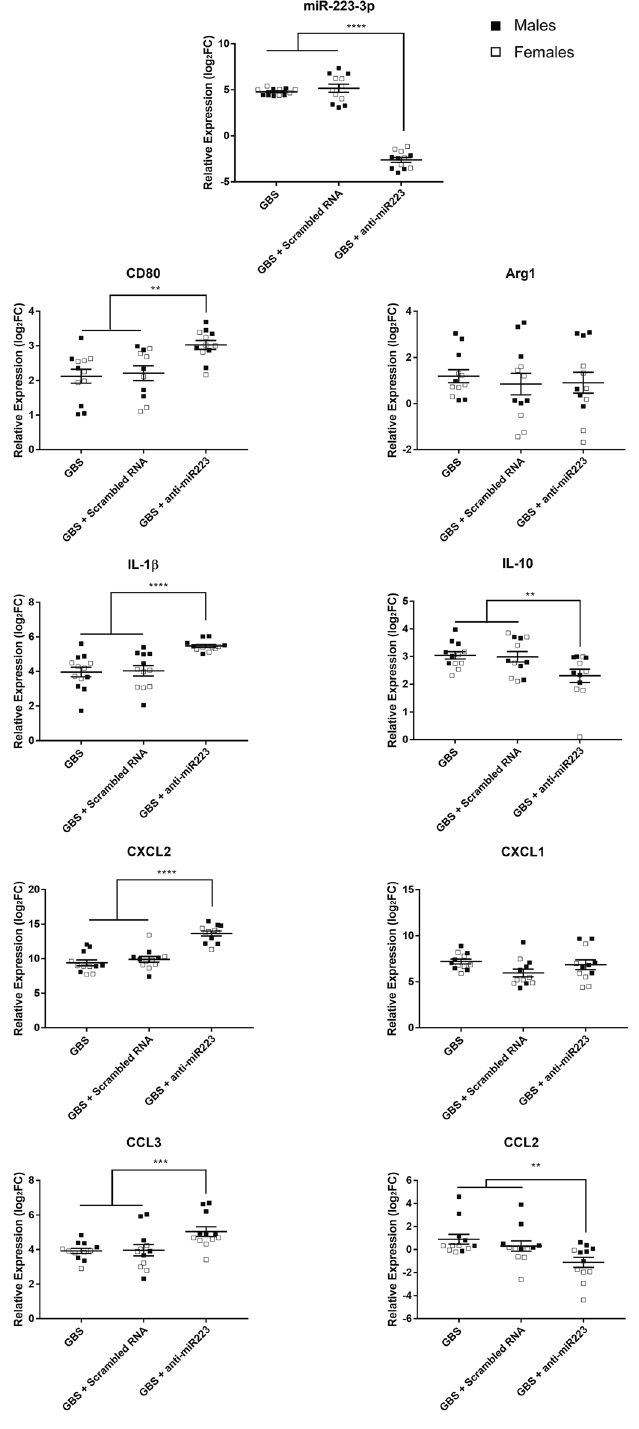
Figure 6. Impact of transient inhibition of miR-223-3p expression by an antagomiR in CD80 and Arg1 as well as pro- and anti-inflammatory cytokines in lung tissue of GBS infected-mice. C57BL/6 male and female mice (n = 6/group) received intranasal injection of GBS alone (± 10 8 CFUs), or 50 µg/50 µL antagomiR-223, or 50 µg/50 µL scrambled RNA, 30 min before GBS infection and checked for changes in mRNAs of interest 6 h pi. The relative expression of miR-223-3p was evaluated in the lungs by real-time RT-qPCR. The values were normalized with two internal controls, snoRNA-202 and snoRNA-234. The relative expression of mRNAs CD80, Arg1, IL-1β, IL-10, CXCL2, CCL3, CCL2 and CXCL1 was evaluated in the lungs by real-time RT-qPCR. The values were normalized with two internal controls, RPL-19 and β-actin. The fold change values (2 −ΔΔCt ) are relative to naive mice matched by sex and age. Data are means ± SD. **p < 0.01, ***p < 0.001, ****p < 0.0001 (Mann–Whitney U test). Data are representative of two independent